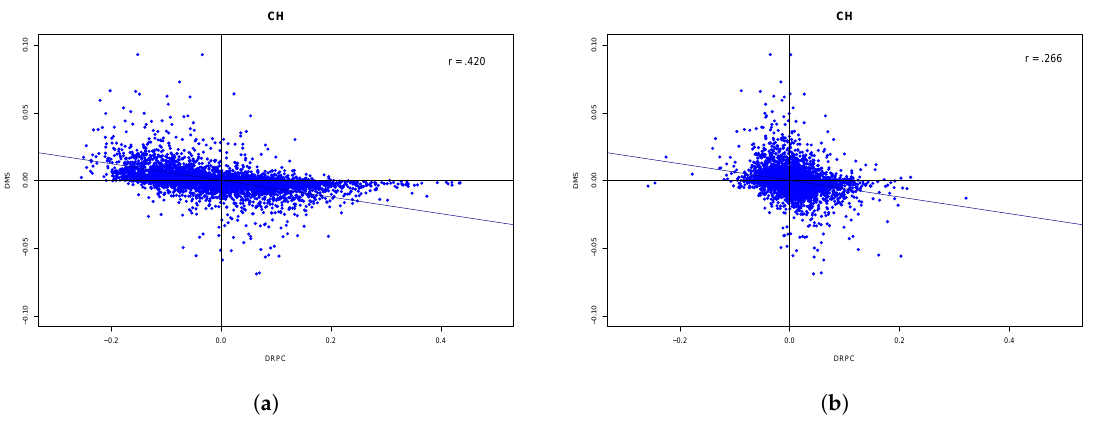
Figure 9. The relationship between DMS and explanatory variables. ( a ) RDPM i , t , c versus DMS i , t , c ; ( b ) DRPC i , t , c versus DMS i , t , c .